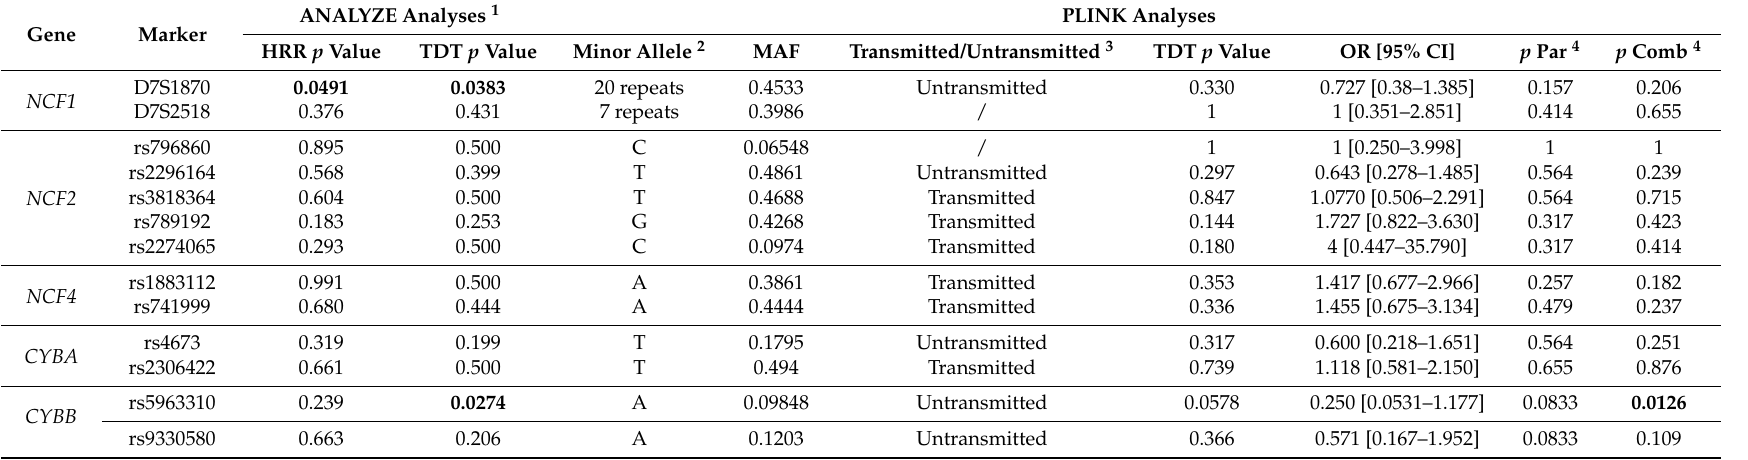
Table 1. NADPH polymorphisms: Results of family-based association TDT and haplotype relative risk (HRR)